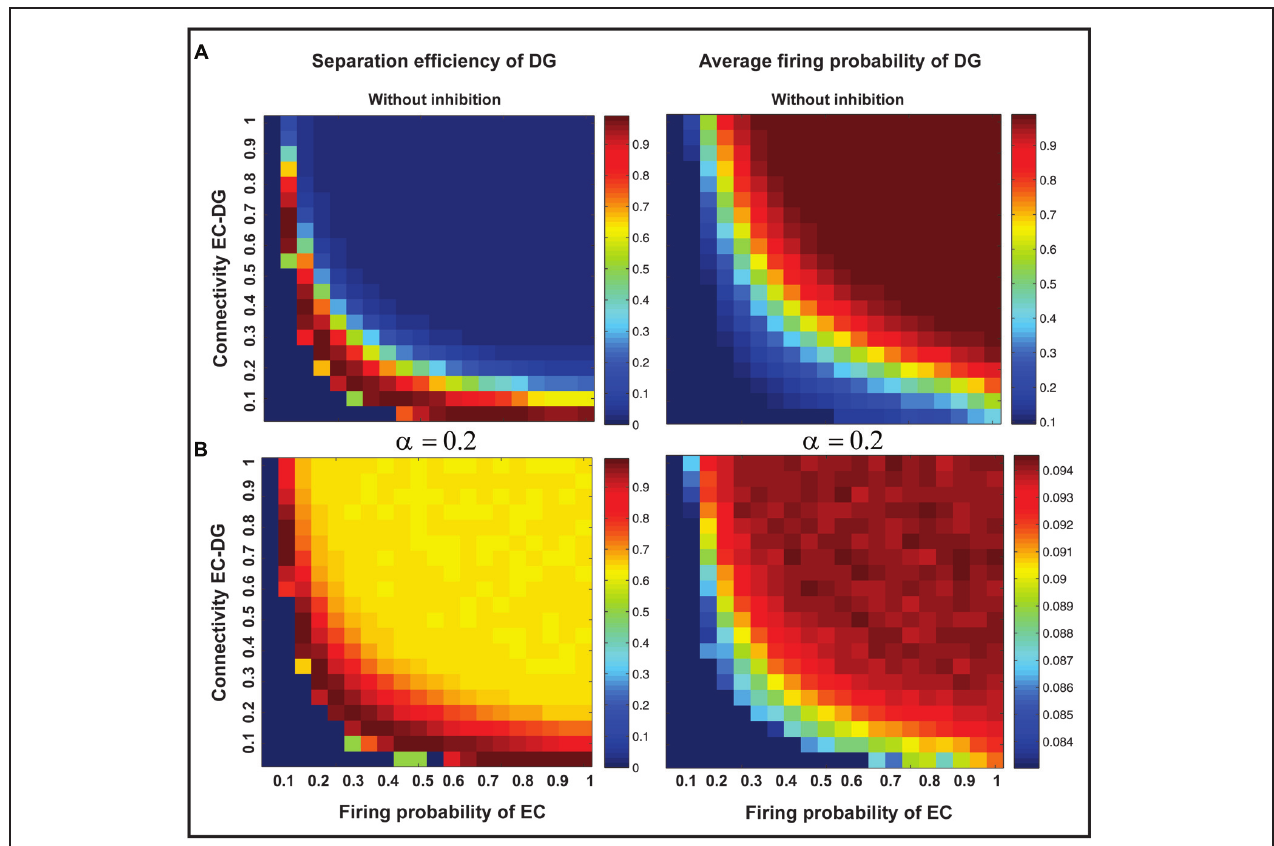
FIGURE 8 | Separation efficiency of the DG versus average firing probability of neurons in the DG. (A) In absence of feedback inhibition separation efficiency is decreased by increase in firing probability of neurons in the EC for connectivity rates higher than 0.1 (left panel) while the average firing probability of activated neurons in the DG is raised (right panel). (B) In